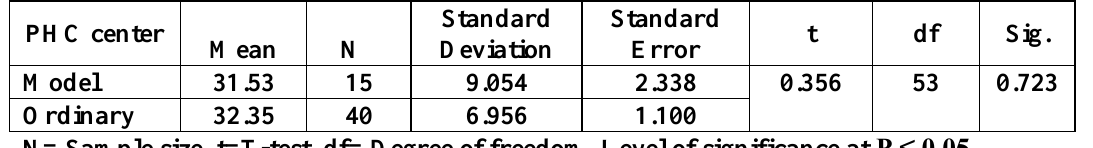
Table (5): Comparative Difference between Model and Ordinary Primary Health Care Centers Managers' Performance of Risk